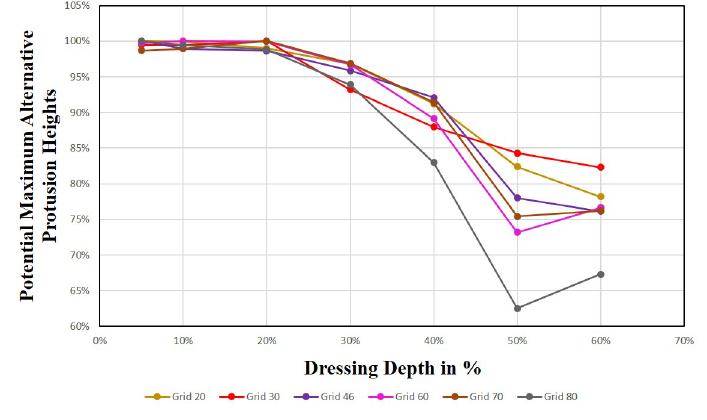
Figure 34. Potential maximum of alternative protrusion height dependent on the percentual dressing depth.